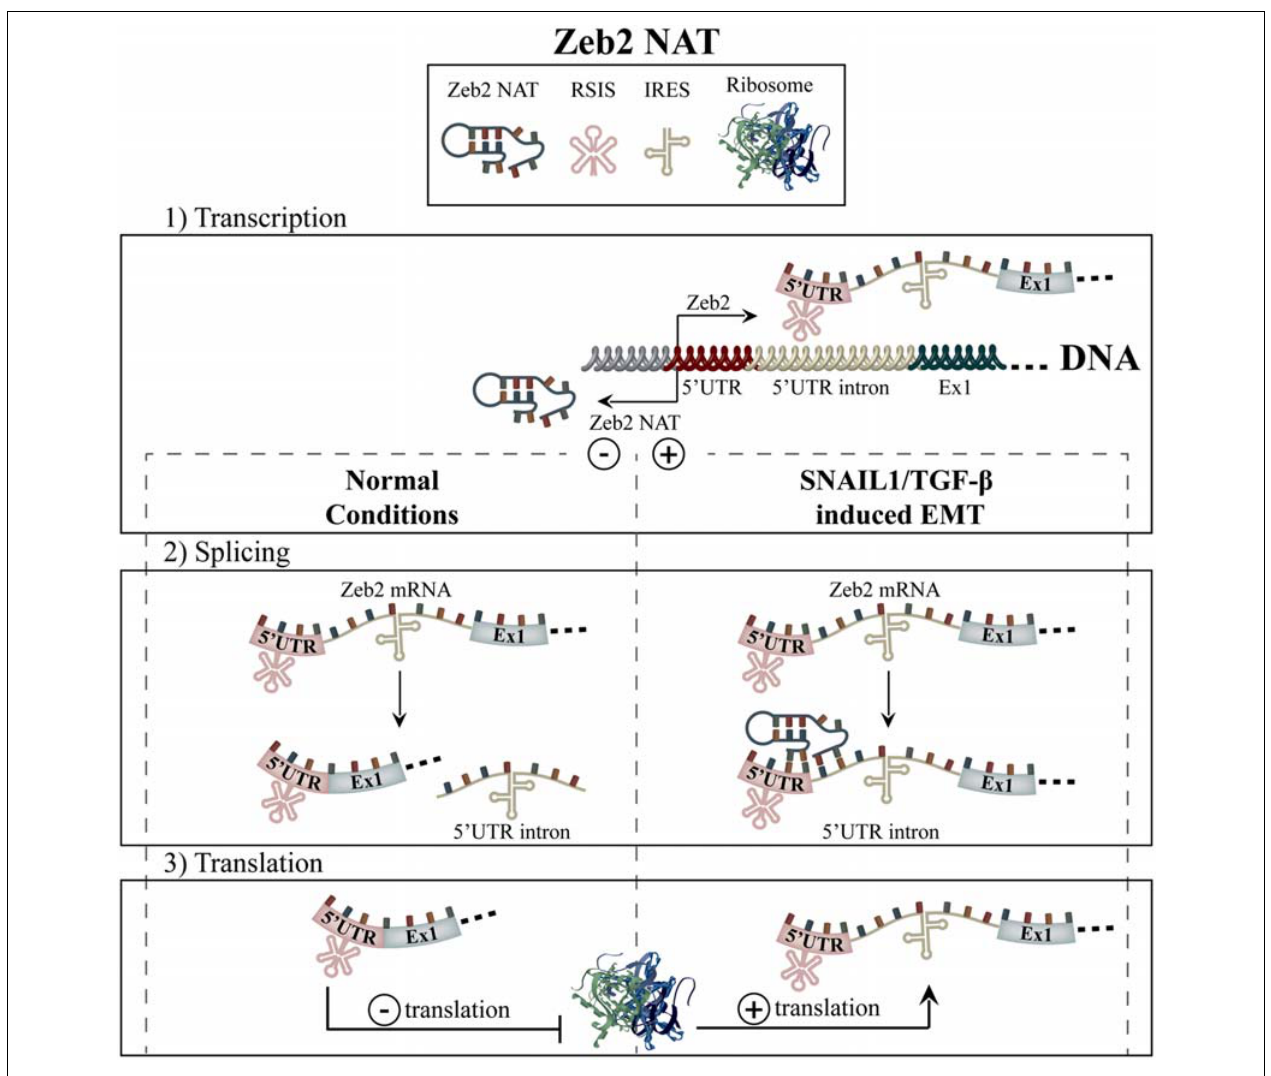
Zeb2 transcripts’ 5 (cid:3) UTR intron by blocking its 5’ splice site (2). An internal ribosome entry sequence (IRES) located in 5 (cid:3) UTR intron then permits increased ribosomal binding and thus, increased translation of Zeb2